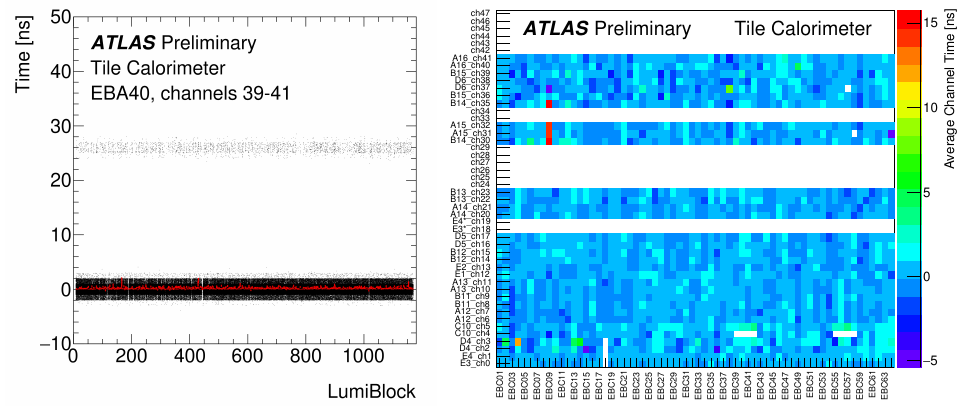
Figure 5. A problem in electronics causes a time offset corresponding to 1 bunch-crossing (25 ns) in a group of three channels in about 1% of events, as determined with the laser events ( left panel) [4]. Another problem causes the reconstructed time in a group of six channels being off by a constant value in all events. The example plot shows affected channels 30–35 (channels 33, 34 are not used) in the module EBC09 and comes from the collision data monitoring ( right panel)